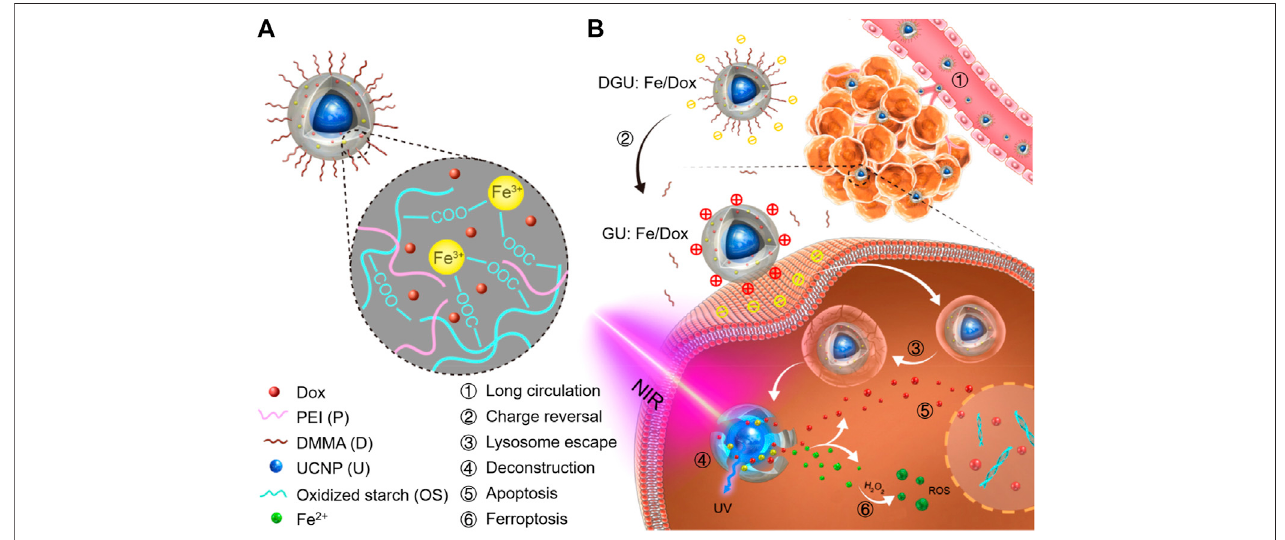
FIGURE 11 | Schematic illustration of AMSNs/DOX for cancer therapy. Adapted from Wang et al., (2018) Copyright @ 2018 (ACS).